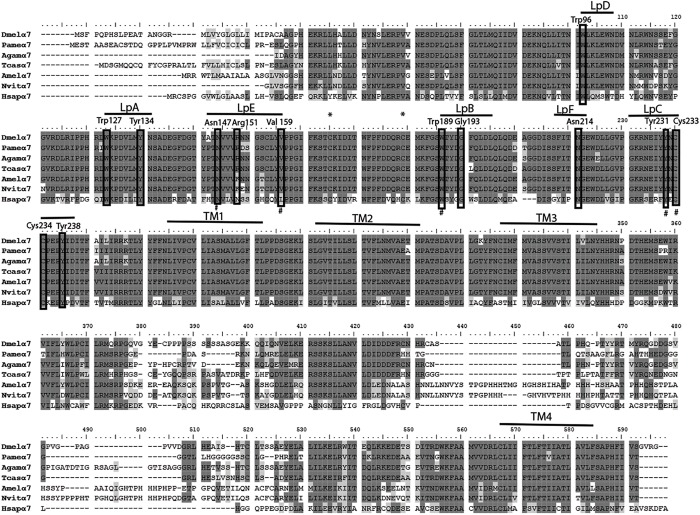
Alignment of nAChR α7 subunit protein sequences of the cockroach P. americana with its orthologs in several insect species and human. The loops (LpA-F) involved in ligand binding and transmembrane motifs (TM1-4) forming the ion channel are indicated. Sites of cysteine residues involved in the Cys-loop are marked with asterisk; the vicinal cysteine residues characteristic of alpha-type and the key residues are shown in frame. Alignment was done with drosophila sequence as reference, identical residues (dark gray shading) and similar residues (light gray shading) are indicated.